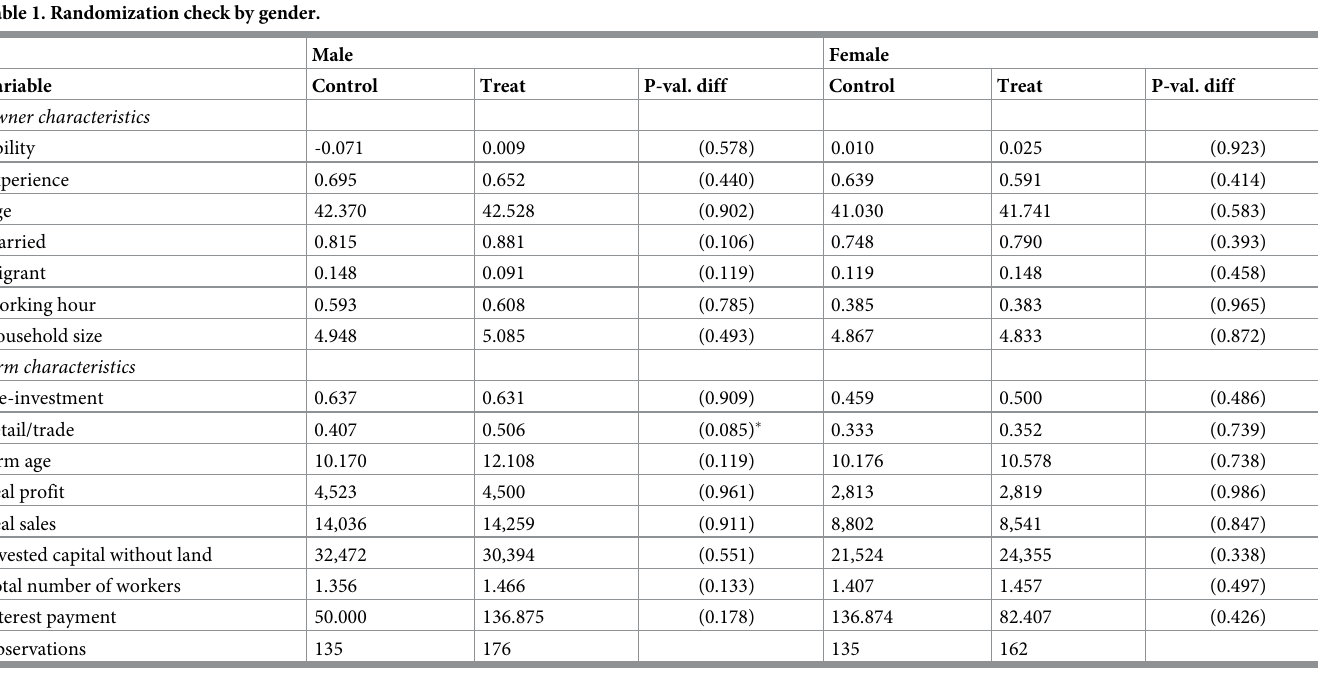
Table 1. Randomization check by